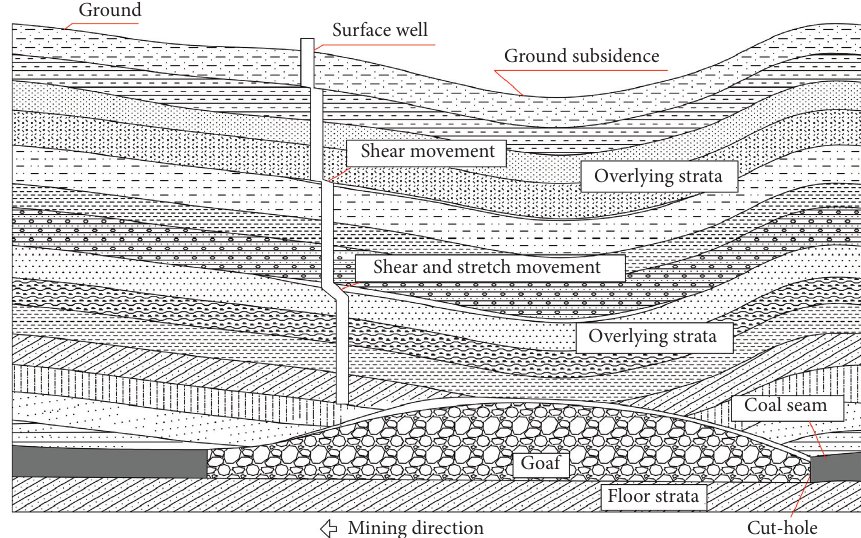
Figure 1: Surface well deformation and failure due to mining-induced rock